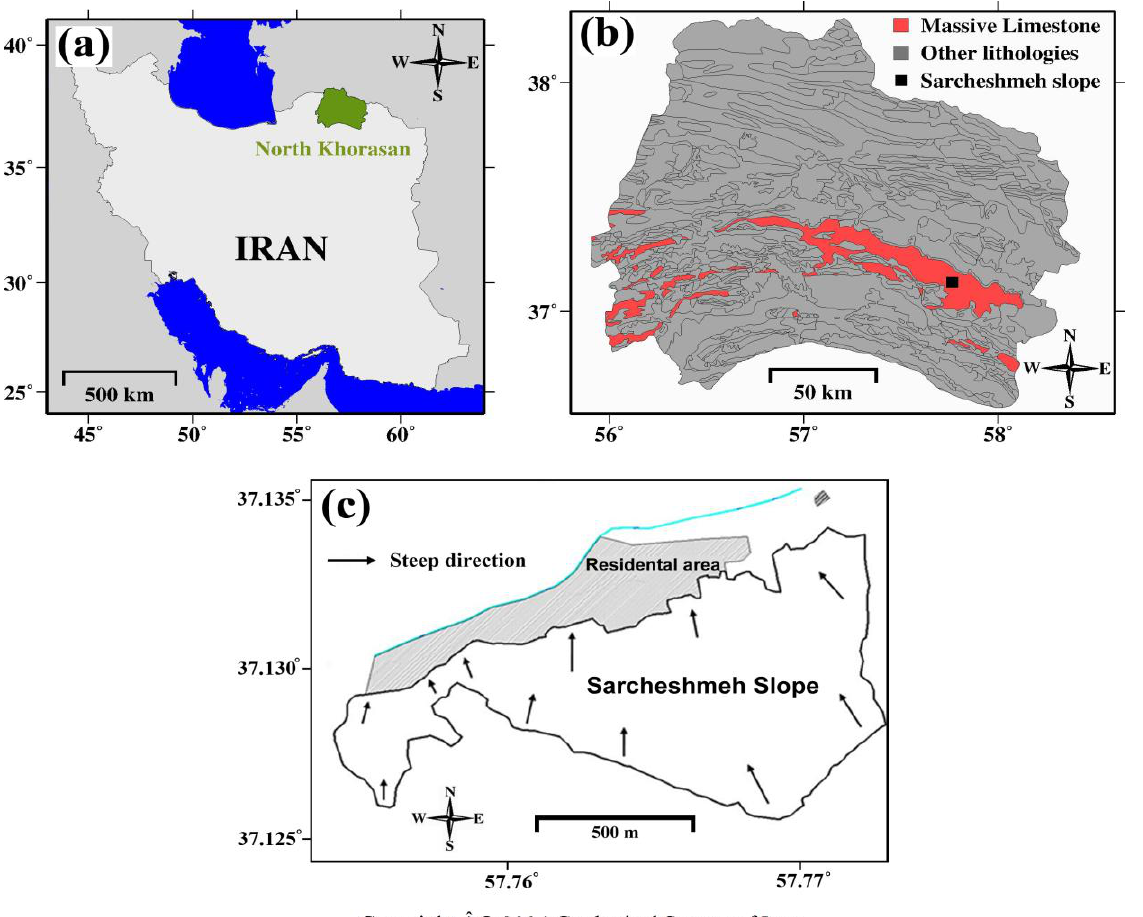
Figure 2. Geology map of the study area: ( a ) Provincial map showing the location of the North Khorasan province (the green area); ( b ) surface geological map of the North Khorasan province with the location of the Sarcheshmeh slope marked by the black rectangle [14]; ( c ) outline of the Sarcheshmeh slope; the black arrows show the main direction of potential